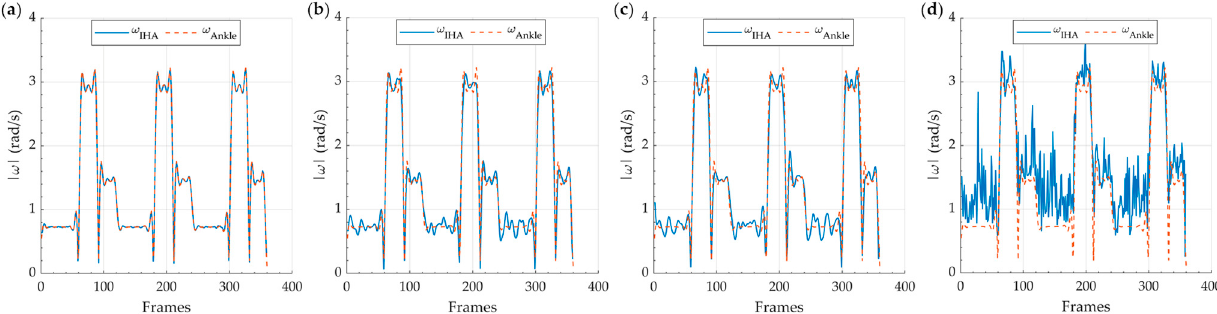
Figure 10. The absolute value of the angular velocity signal, as imposed by the model ( ω Ankle , dashed line) in motion configuration A, and as estimated by the IHA algorithm ( ω IHA ). The plots were obtained by considering SNR rnd = 100 dB, and different levels of common noise signal: ( a ) SNR cmn = 100 dB; ( b ) SNR cmn = 90 dB; ( c ) SNR cmn = 80 dB; ( d ) SNR cmn = 70 dB.